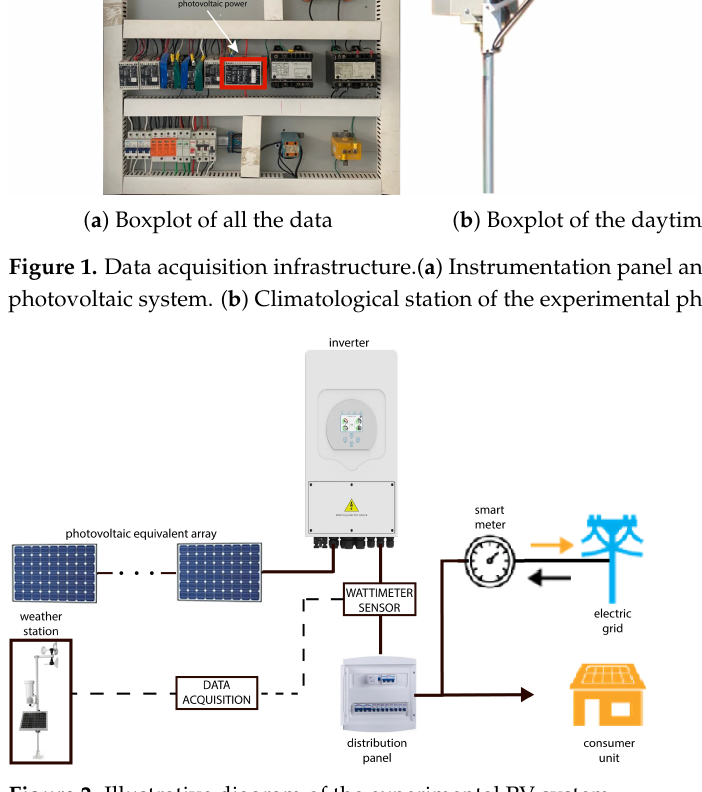
Figure 2. Illustrative diagram of the experimental PV